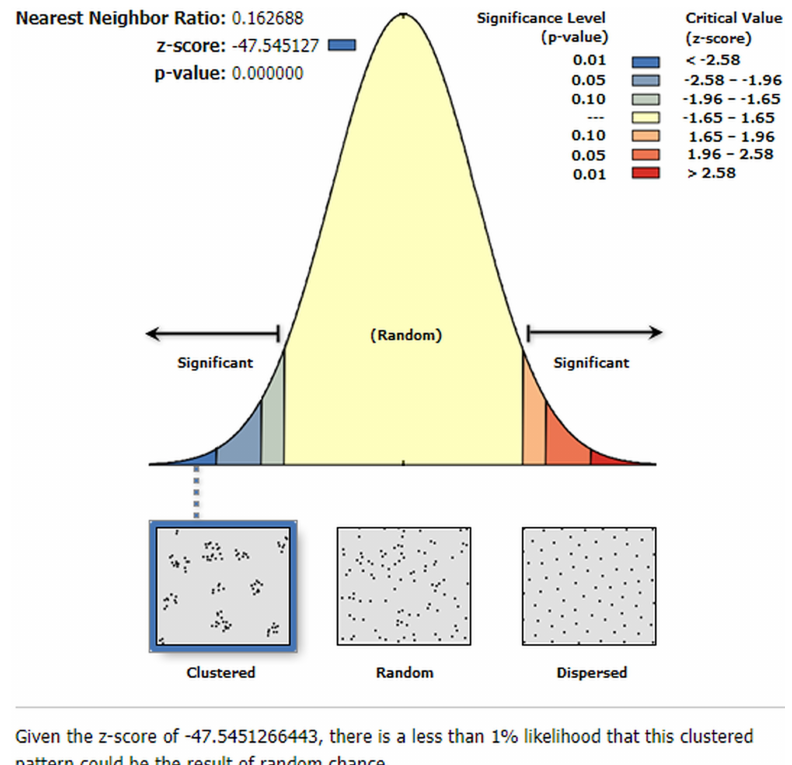
Figure 4. Visualization of crime cases on the basis of each crime type using